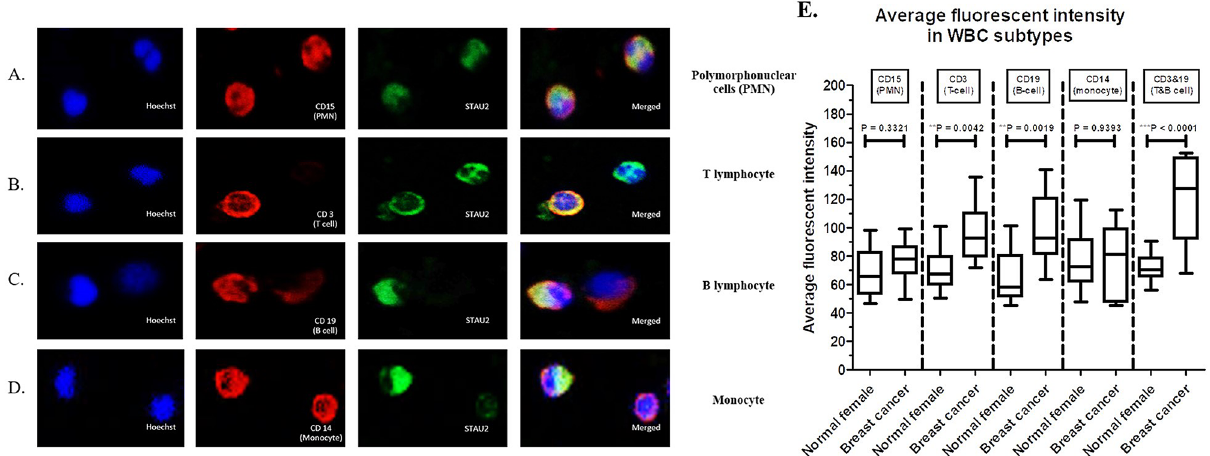
Figure 3. Subtypes of WBCs from breast cancer patients were identified based on specific antibodies, including ( A ) anti-CD15 + for polymorphonuclear cells (PMNs); ( B ) anti-CD3 + for T lymphocytes; ( C ) anti-CD19 + for B lymphocytes; and ( D ) anti-CD14 + for monocytes. A positive fluorescent signal was observed in all WBC subtypes. ( E ) The intensity of the anti-STAU2 fluorescent signal was significantly increased in CD3 + T-cells ( p = 0.0042) and CD19 + B-cells ( p = 0.0019). The combination of CD3 + and CD19 + , which refers to the group of T and B lymphocytes, exhibited a notable increase in the average fluorescence intensity ( p < 0.0001). The intensity detection was operated by CellSens imaging software (Olympus Co., Ltd.,